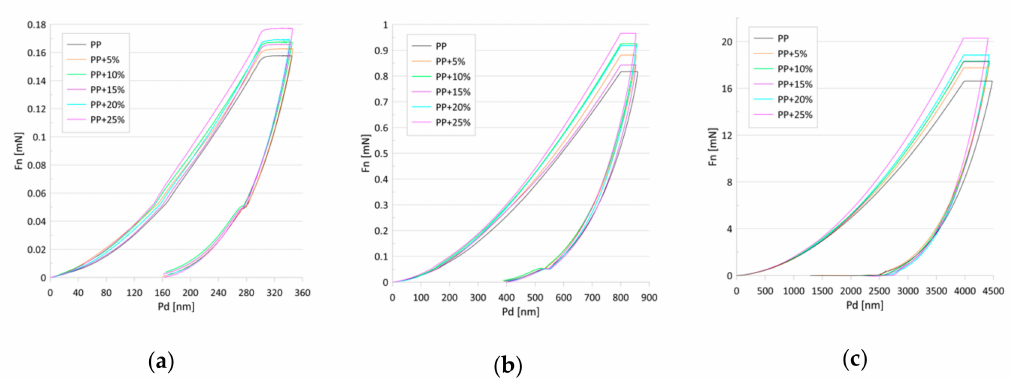
Figure 4. Load (Fn)–penetration depth (Pd) curves for the tested samples for penetration depths of ( a ) 300, ( b ) 800, and ( c ) 4000 nm.